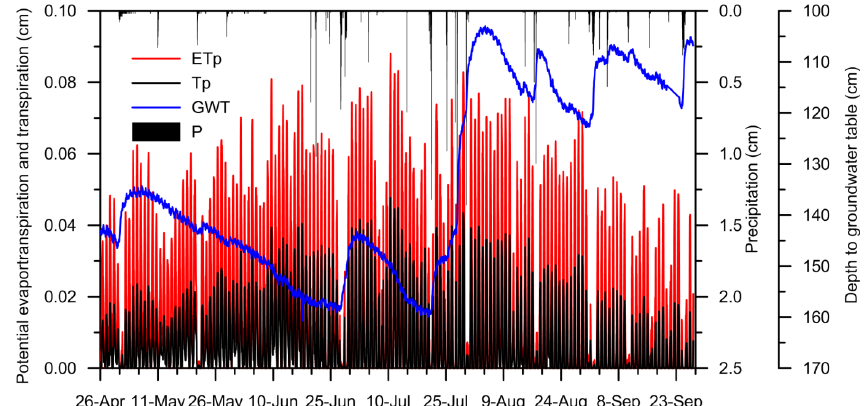
Figure 3. Summary of the modeled soil column boundary conditions (P = precipitation; ETp = potential evapotranspiration; Tp = transpiration; GWT = depth to groundwater table). The upper and lower boundary conditions for heat transport were specified as temperature boundary conditions. The upper boundary values were given as the observed temperatures at 0.02 cm, and the lower boundary values were given as the groundwater temperature. The initial soil water content and soil temperature were determined from the measured values on April 26 at 0:00 h by interpolating the measured values between different depths.